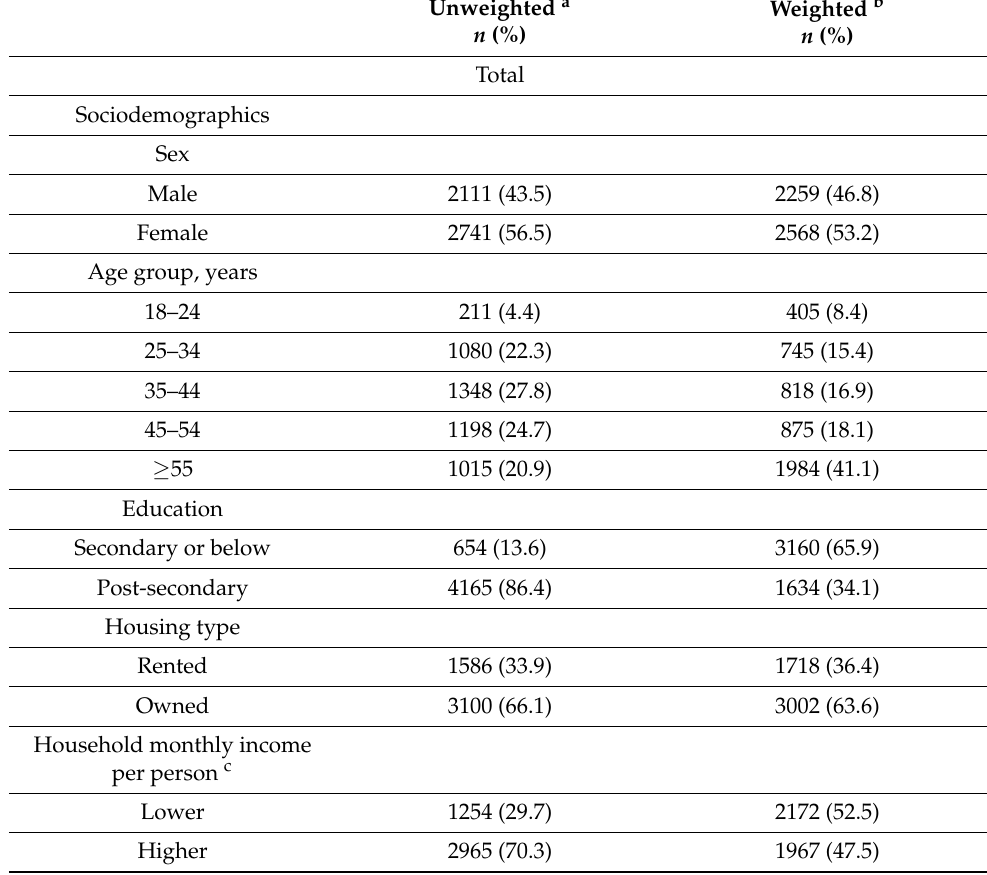
Table 1. Characteristics of the survey sample ( n =